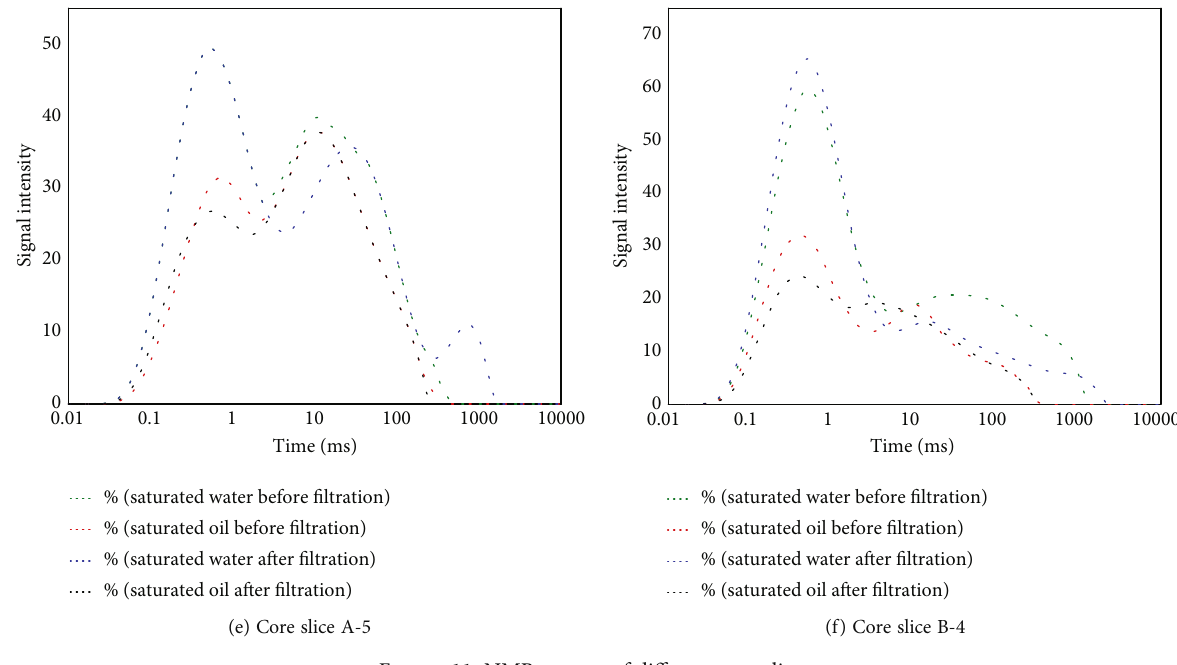
Figure 11: NMR spectra of di ff erent core slices. Table 3: Mixed wettability test results of di ff erent core